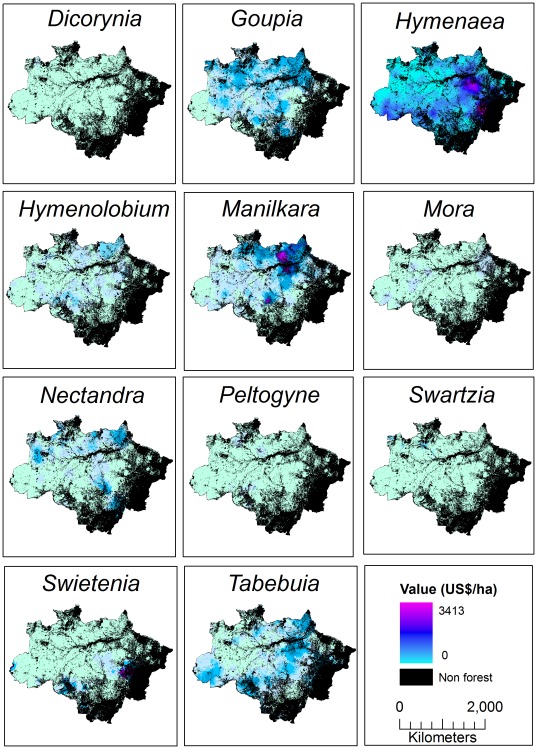
Predicted timber value across the Amazon by genus.Each of the 11 high-value genera, show genus-specific spatial patterns in the distribution of timber value and differences in total value (US$.ha−1). Hymenaea appears to consistently have the highest value across the Amazon. Other genera, such as Manilkara, Nectandra and Tabebuia show ‘hotspots’ of high values in relatively restricted areas of the Amazon. Some genera, such as Dicorynia and Peltogyne, show lower values that do not vary much across space.